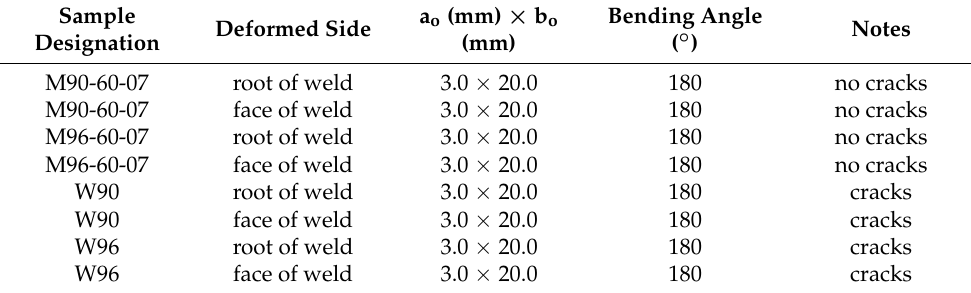
Table 3. Bending tests